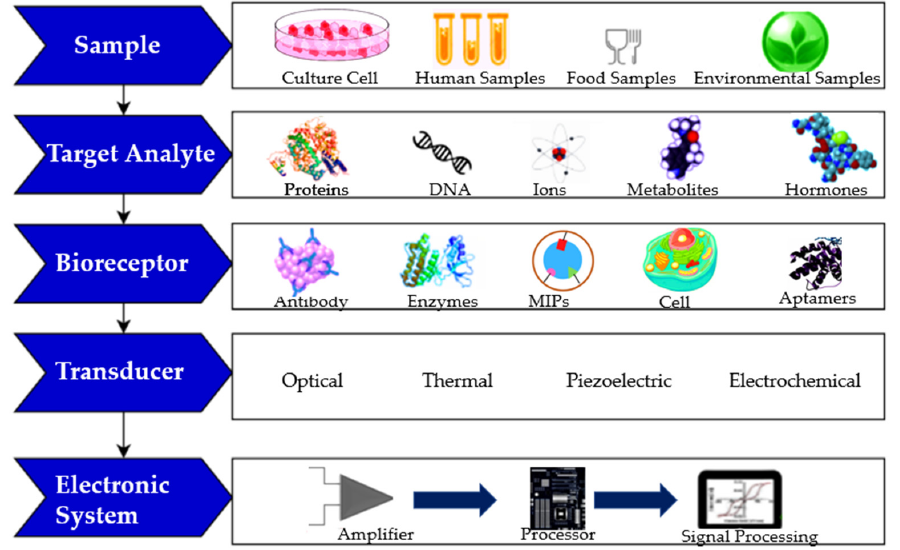
Figure 6. Possibilities of different components of a biosensor [49].